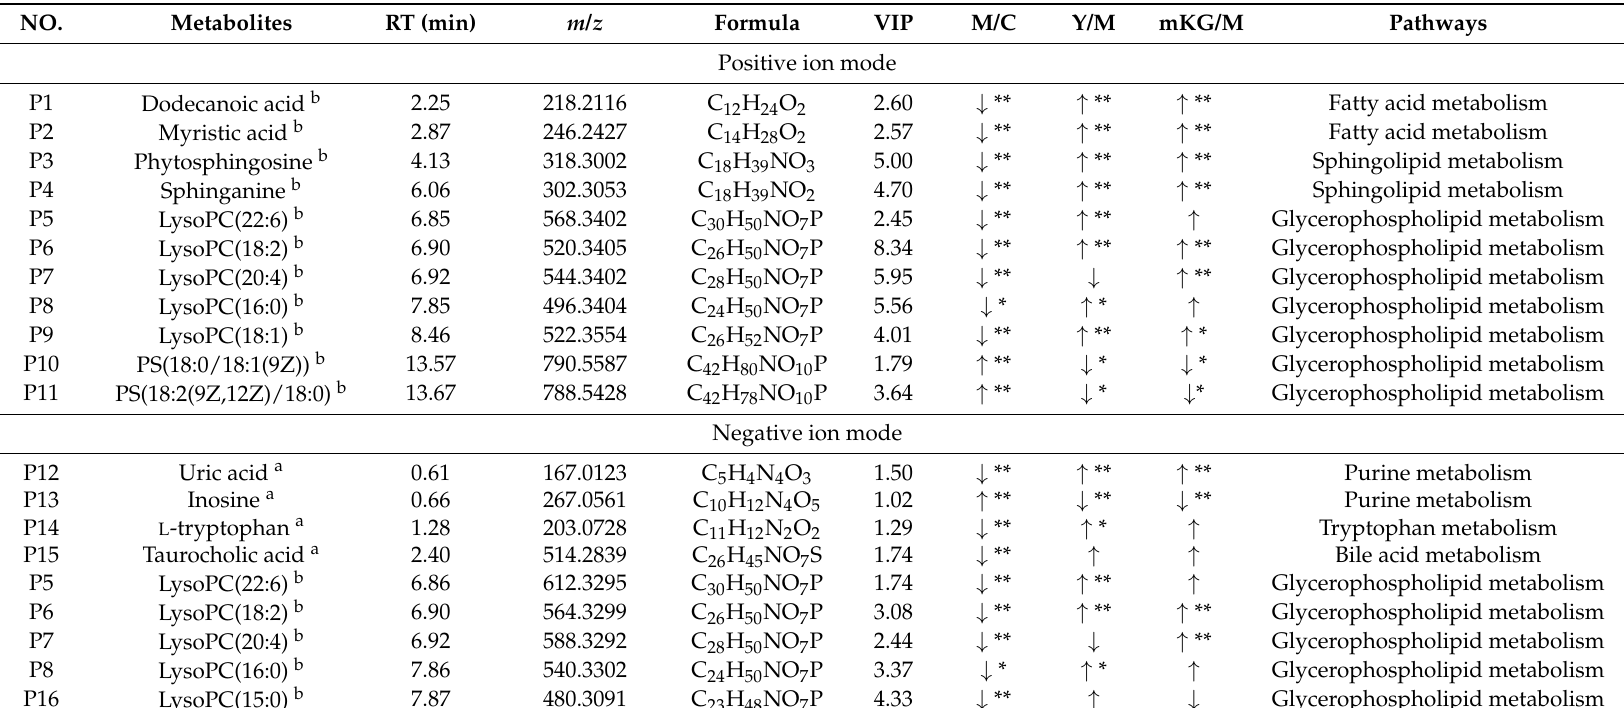
Table 3. Potential biomarkers characterized in the plasma profile and their change trends in different